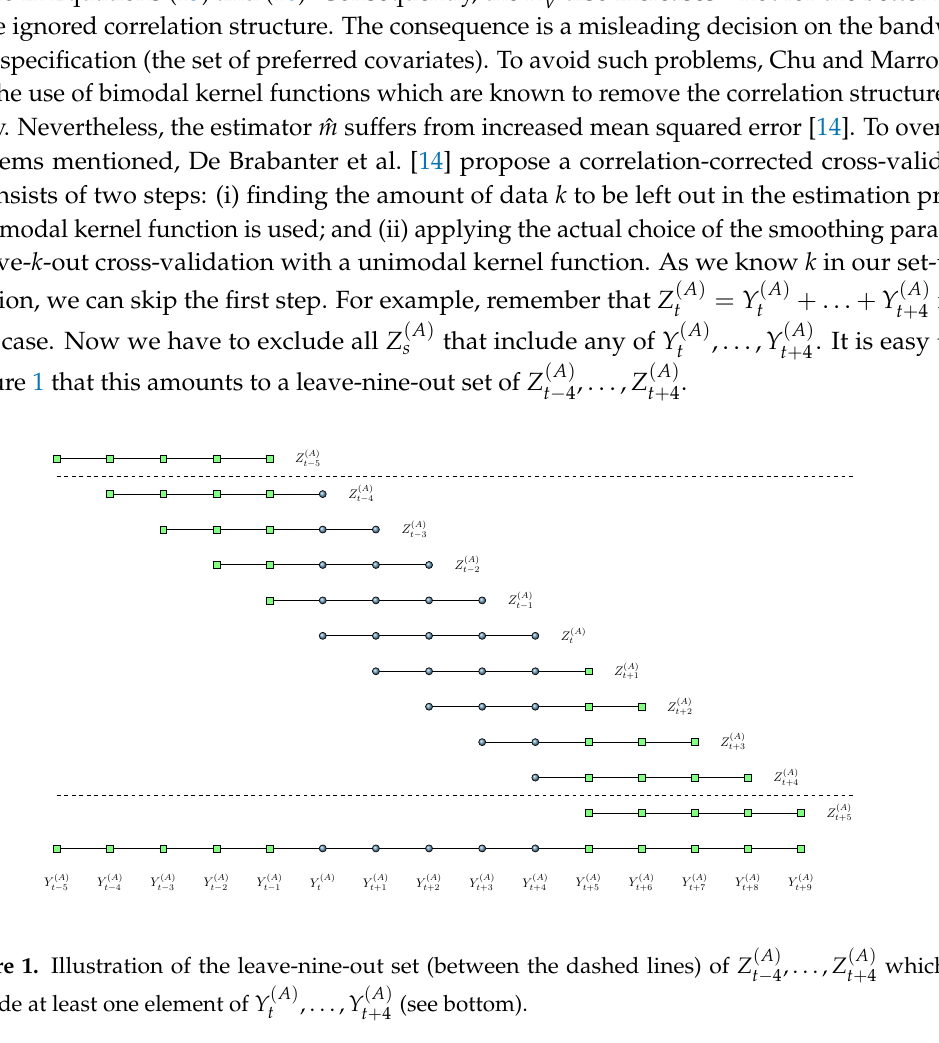
( A ) ( A ) , . . . , Z which t − 4 t + 4